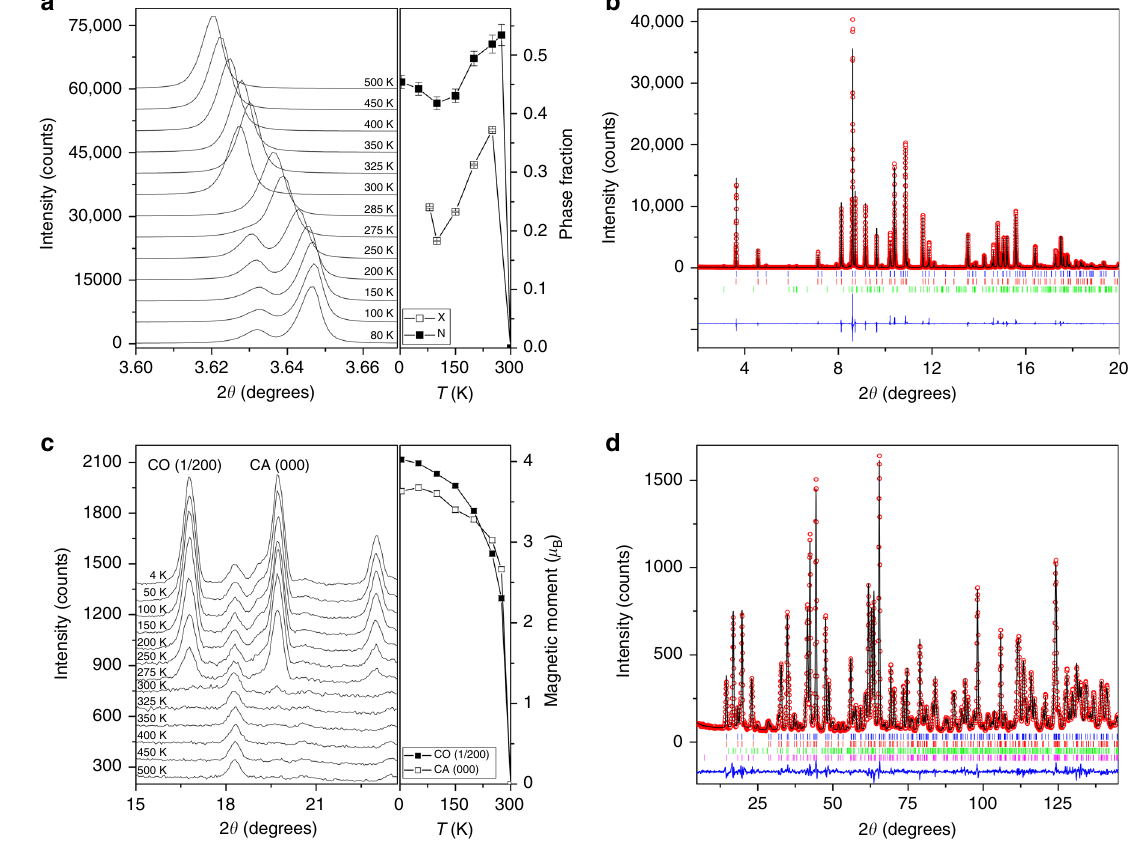
Fig. 2 Electronic phase separation of CaFe 3 O 5 . a Evolution of the X-ray (002) peak which shifts to lower 2 θ when cooled to 300 K, just below the T = 302 K transition, with separation into two components at lower temperatures. The phase fractions of the charge averaged (CA) phase, obtained from M synchrotron (X) and neutron (N) diffraction data are shown in the right-hand panel. Error bars are the estimated standard deviations calculated during pro fi le fi tting. b Rietveld fi t to synchrotron powder diffraction pro fi les for CaFe 3 O 5 at 80 K (R-factors R p = 9.35 %, R wp = 11.0 %), with blue and red tick marks indicating the two low temperature phases and green marks 2.3% of Ca 2 Fe 2 O 5 impurity. c The appearance of the magnetic re fl ections with propagation vectors of (000) for the CO phase and (½00) for the charge averaged (CA) phase below 302 K and the temperature evolution of their magnetic moments. d The Rietveld fi t to neutron powder diffraction pro fi les for CaFe 3 O 5 at 4 K (R-factors R p = 6.14 %, R wp = 7.28 %), with structural phases indicated with blue and red tick marks. The green and pink tick marks represent the magnetic phases with propagation vectors of (½00) and (000) NATURE COMMUNICATIONS| (2018) 9:2975 |DOI: